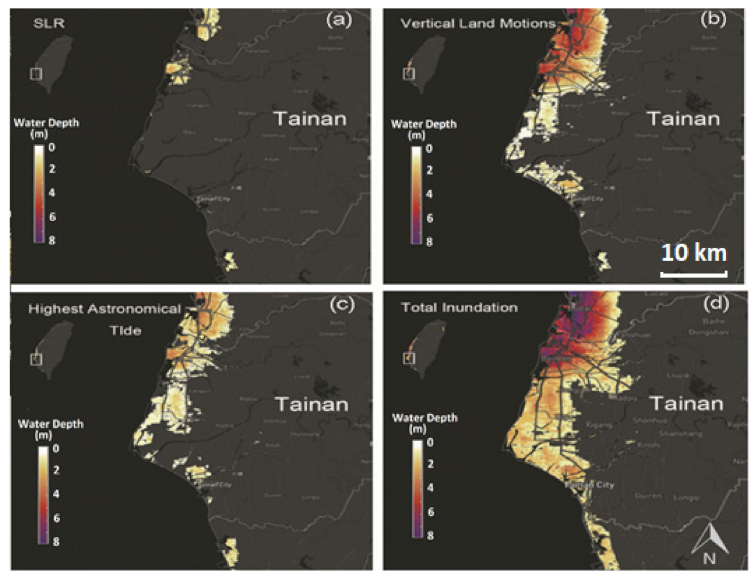
Figure 7. Inundation map (m) for Tainan under different inundation situations: SLR ( a ), Vertical Land Motion ( b ), Highest Astronomical ( c ), and Total Inudation ( d